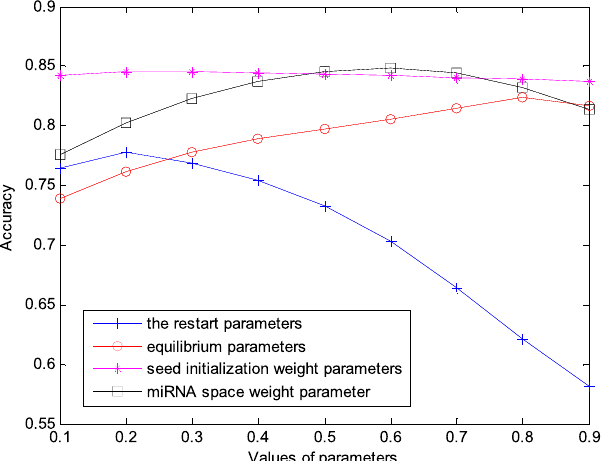
Figure 1. The effect of parameters on the GSTRW